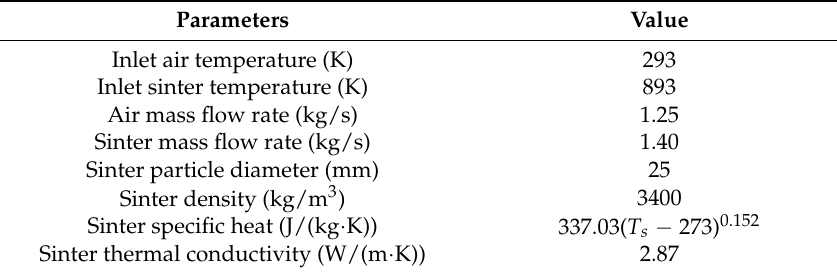
Table 1. Main parameters of one condition.